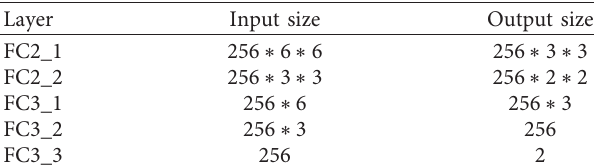
Table 4: The structure of FC2-3 in Figure 5.